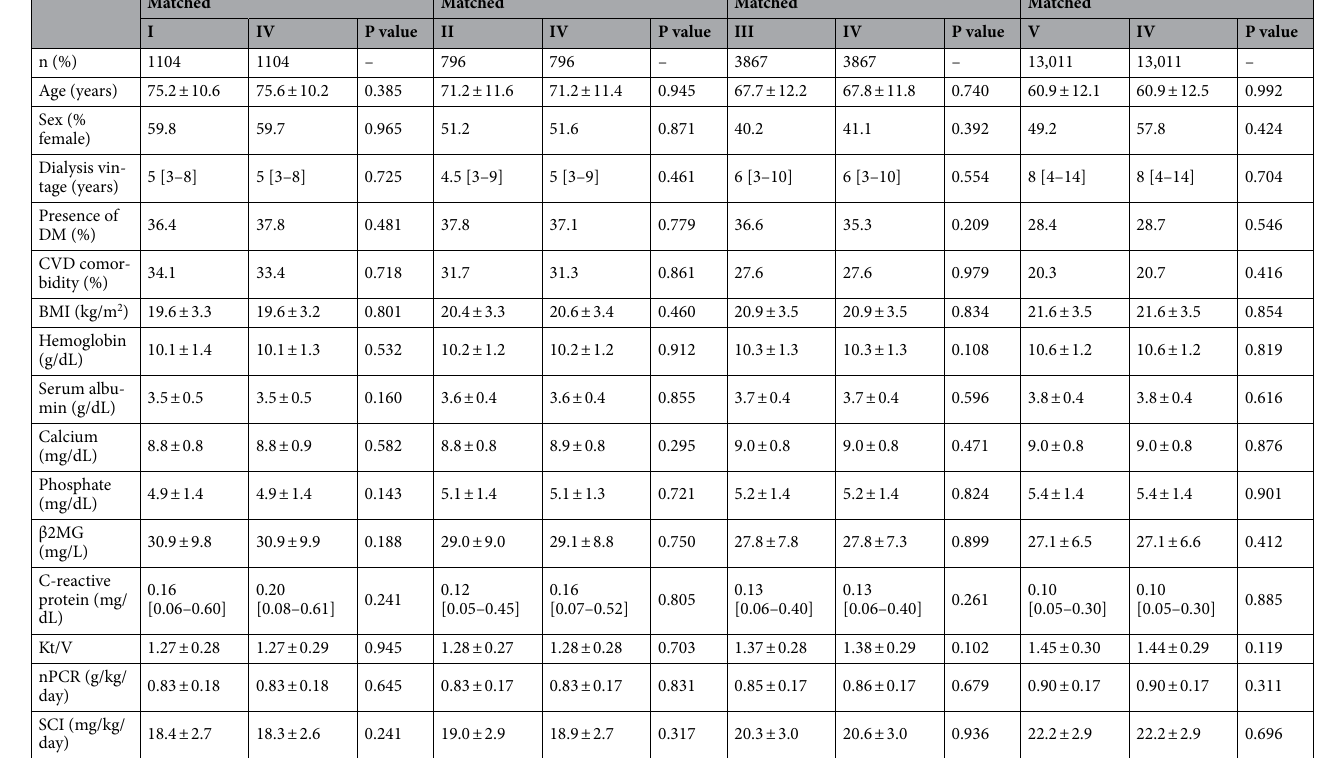
Table 4. Baseline characteristics after propensity score matching between type IV and other types of dialyzers. β2MG β